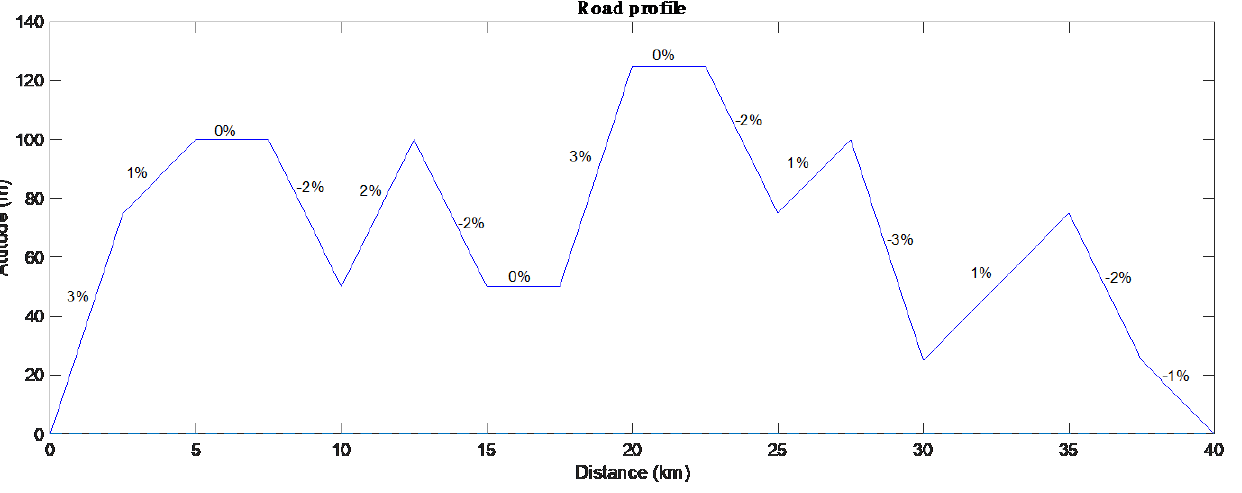
Table 3. Coasting speeds (mph) of trucks with different